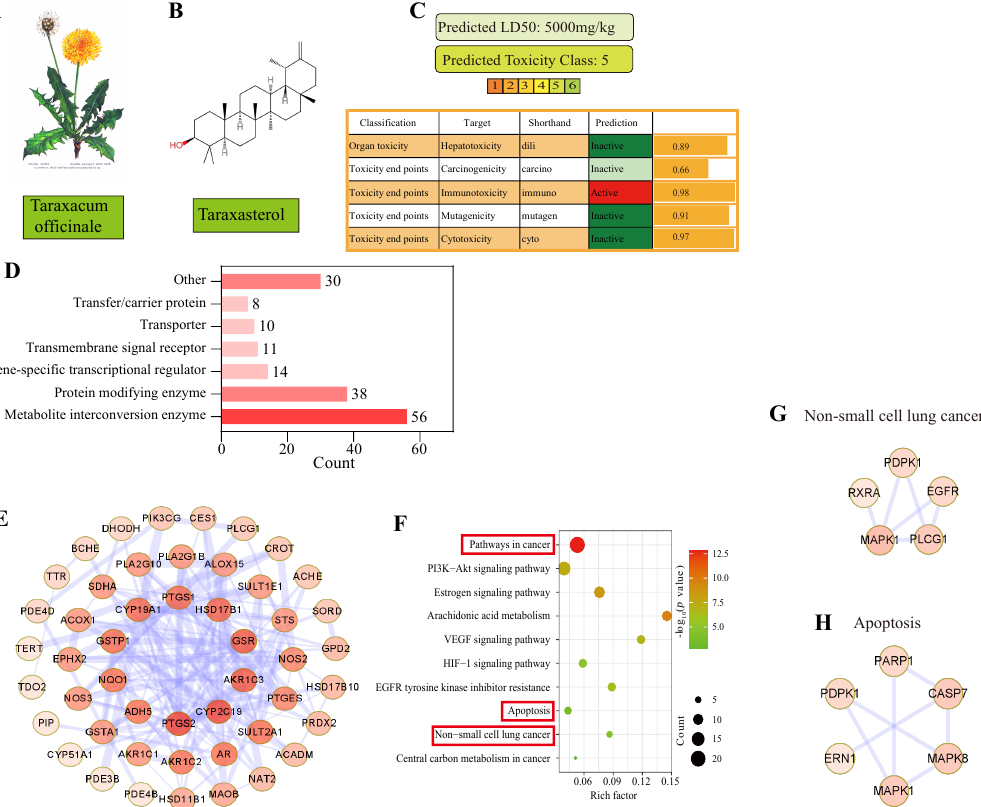
Figure 3. Predicting the targets and safety evaluation of TAX by network pharmacology. ( A ) The image of Taraxacum officinale. ( B ) Using the online structural editor InDraw according to smile number (http://indrawforweb.integle.com/ (accessed on 1 May 2021)) Mapping the 2D chemical structure of TAX. ( C ) Using the ProTox-II Database (https://tox-new.charite.de/protox_II/ (accessed on 1 May 2021)), predicting the drug safety of TAX. ( D ) Acquisition of the targets of action of TAX. ( E ) Construction of a protein-protein interaction (PPI) network. ( F ) KEGG enrichment analysis. ( G , H ) construction of a protein-protein interaction (PPI) network involved in non-small cell lung cancer (hsa05223) versus apoptosis